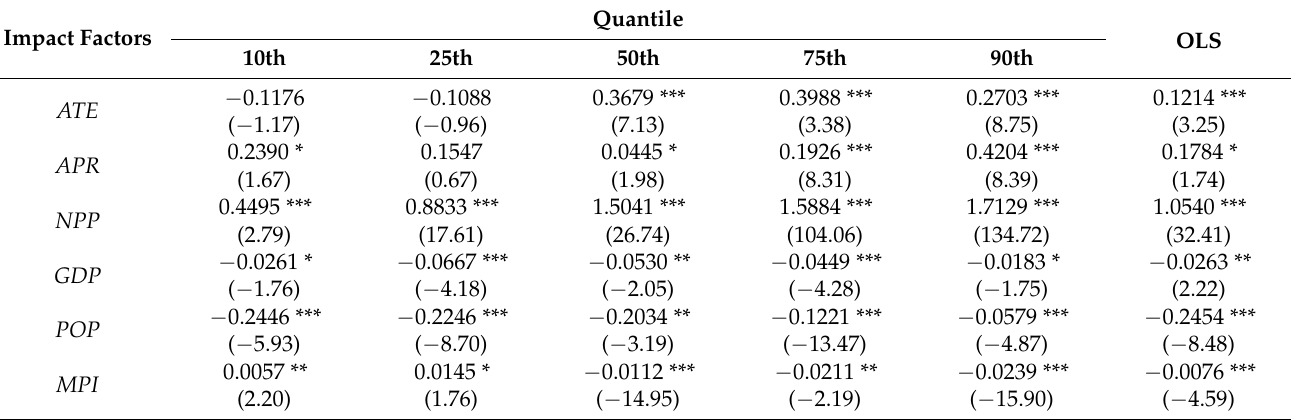
Table 5. Regression estimation results from a panel quantile model of ESV impact factors.